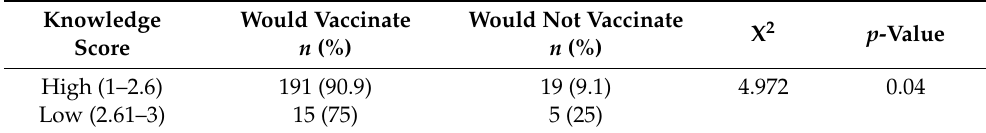
Table 2. Relationship between COVID-19 knowledge score and willingness to